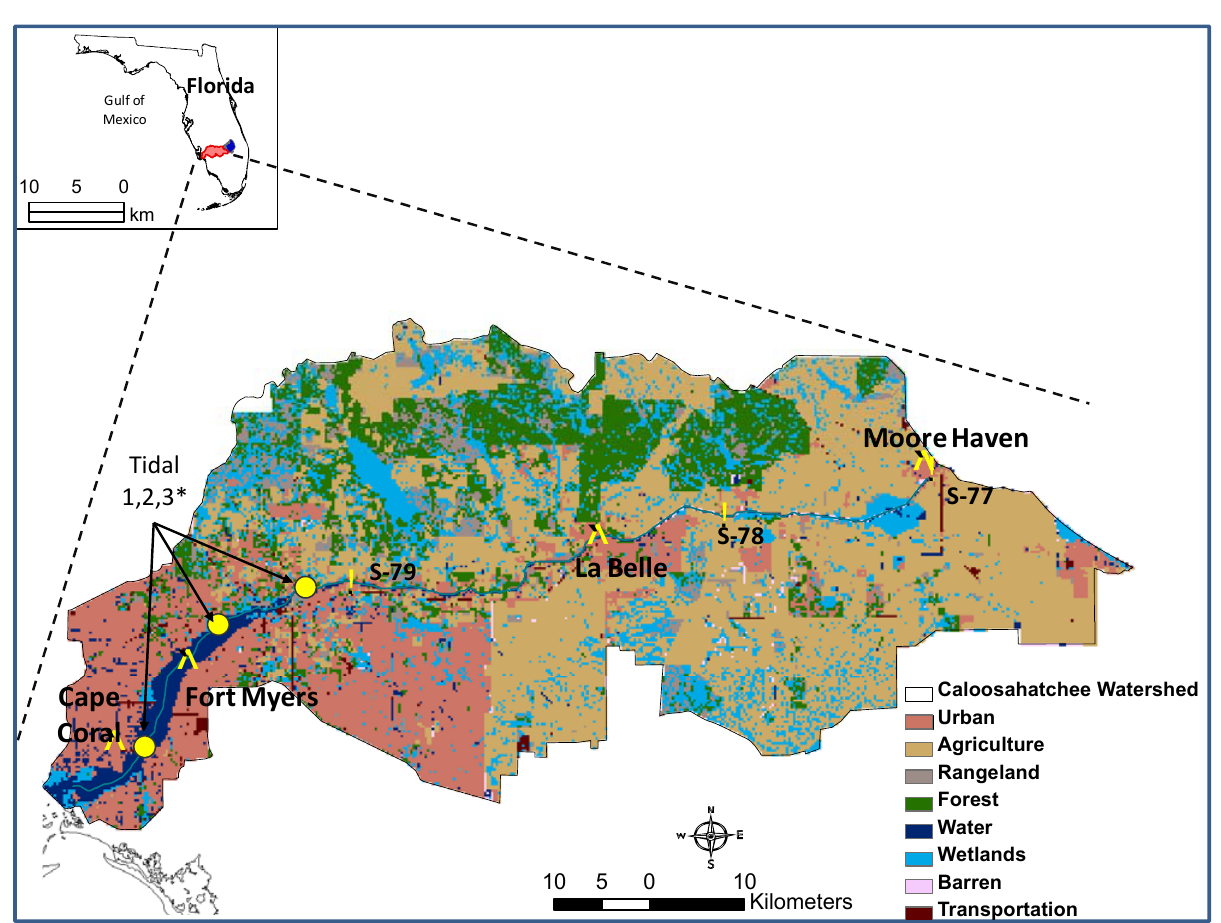
Figure 1. Caloosahatchee River Watershed location, major cities and gauging stations and 2008 land use. *Stations are designated Tidal 1, Tidal 2, and Tidal 3, going downstream from navigational point S-79, in that